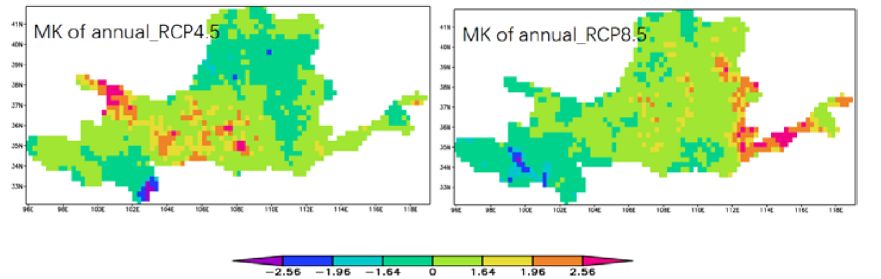
Figure 6. MK trend of annual streamflow for RCP4.5 and RCP8.5 from 2021 to 2050 in YRB.